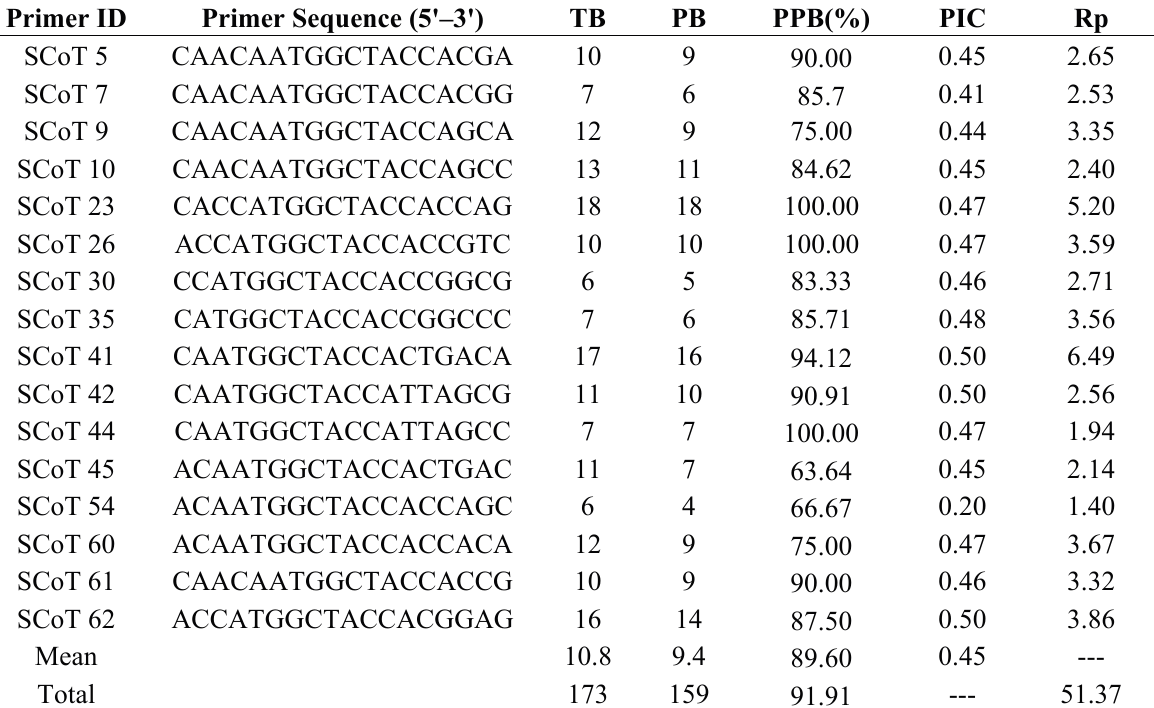
Table 2. 16 SCoT primers used to genotype E. sibiricus accessions, cultivars and breeding line, the total bands (TB), polymorphic bands (PB), percentage of polymorphic bands (PPB). Polymorphic information content (PIC), and resolving power of primer